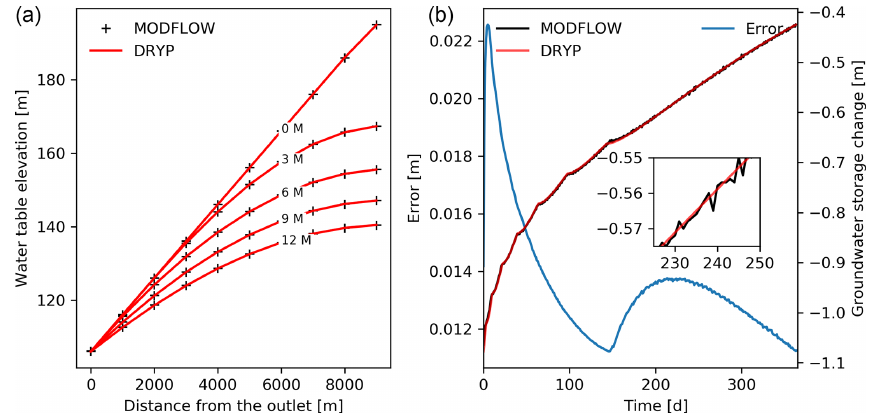
Figure 6. (a) Simulated head along the aquifer for different time steps (in months, represented using “M” in panel a ) estimated by DRYP (solid lines) and MODFLOW (dashed lines), and (b) temporal variation in the mass balance error for DRYP.